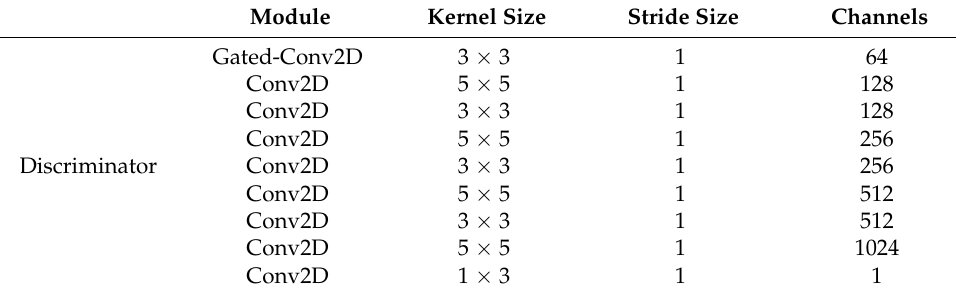
Table 2. Parameter setting of BSEGAN-SI Discriminator.